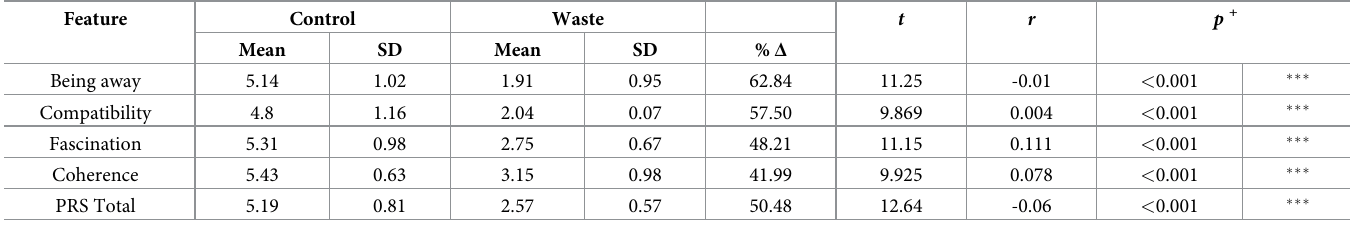
Table 3. Results of t-test comparison between control and waste settings (Perceived Restorativeness